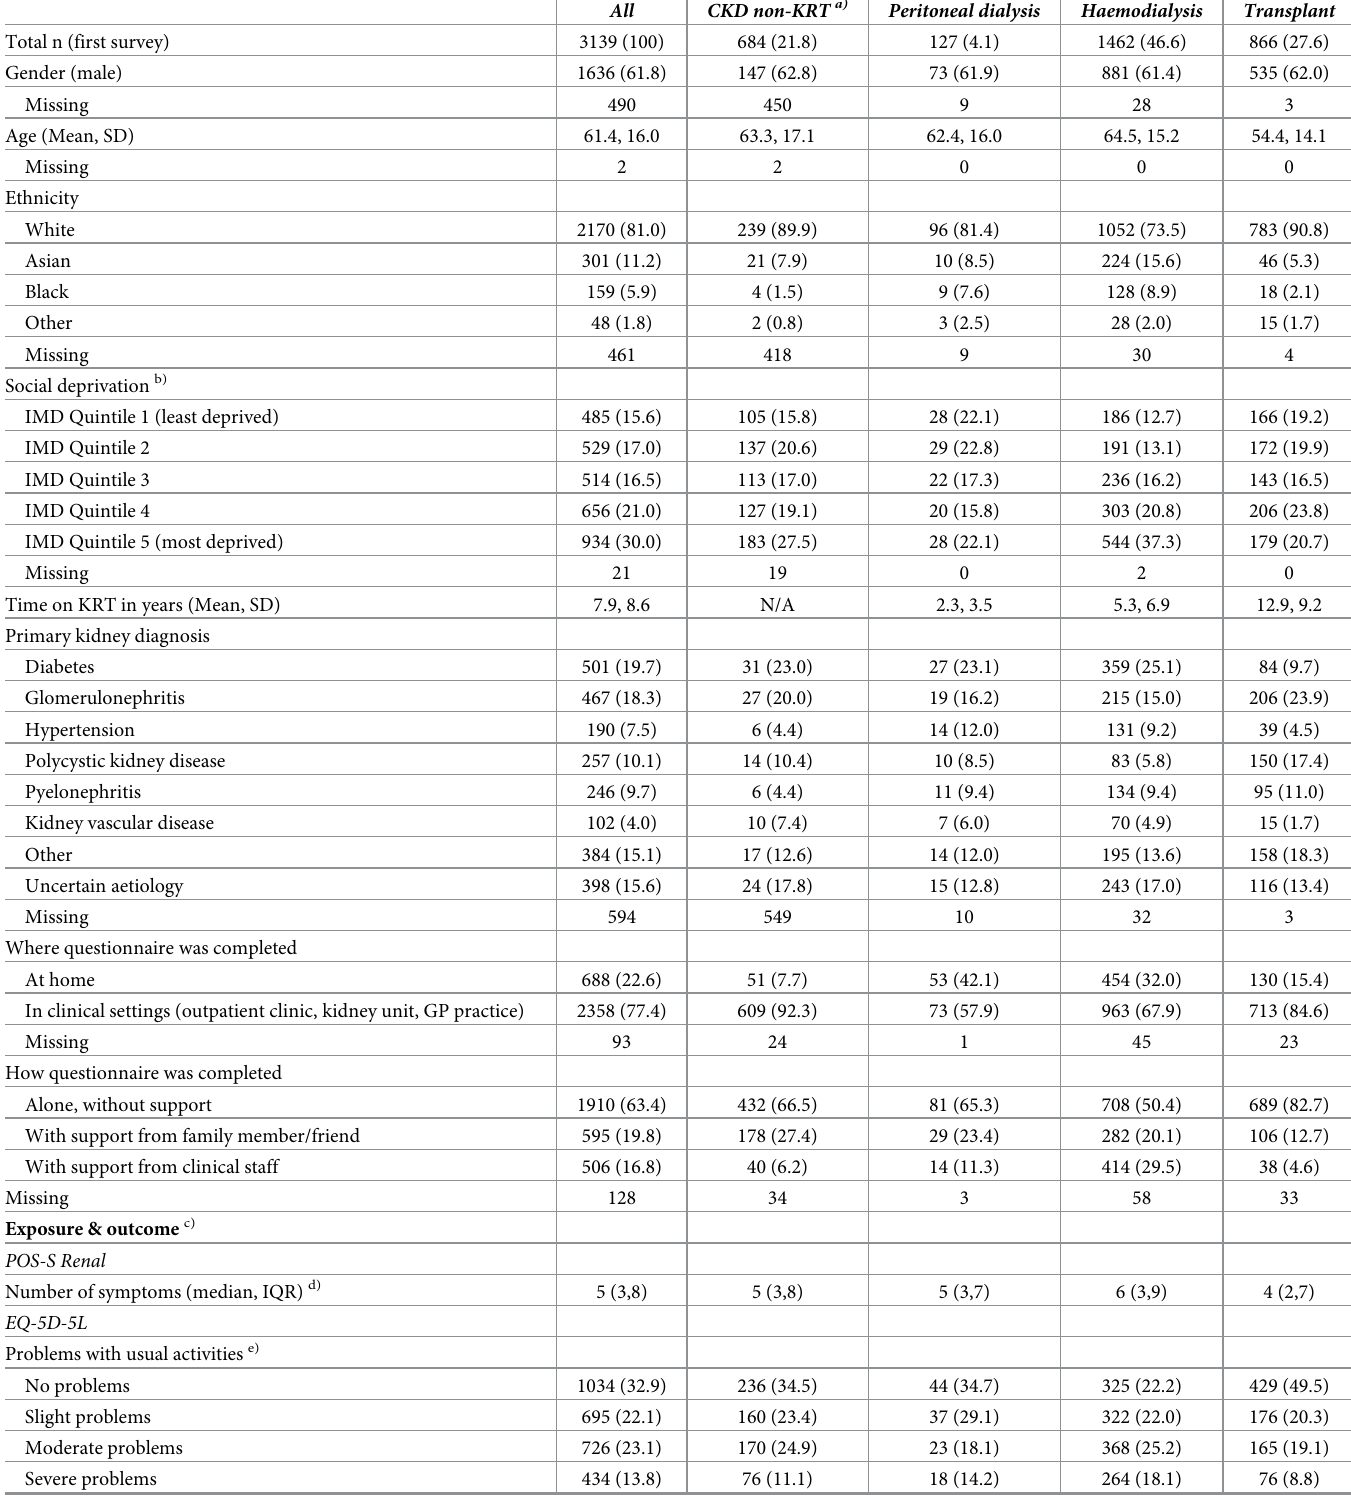
Table 1. Baseline characteristics of people included in our analyses (values are numbers (% after excluding missing), unless indicated